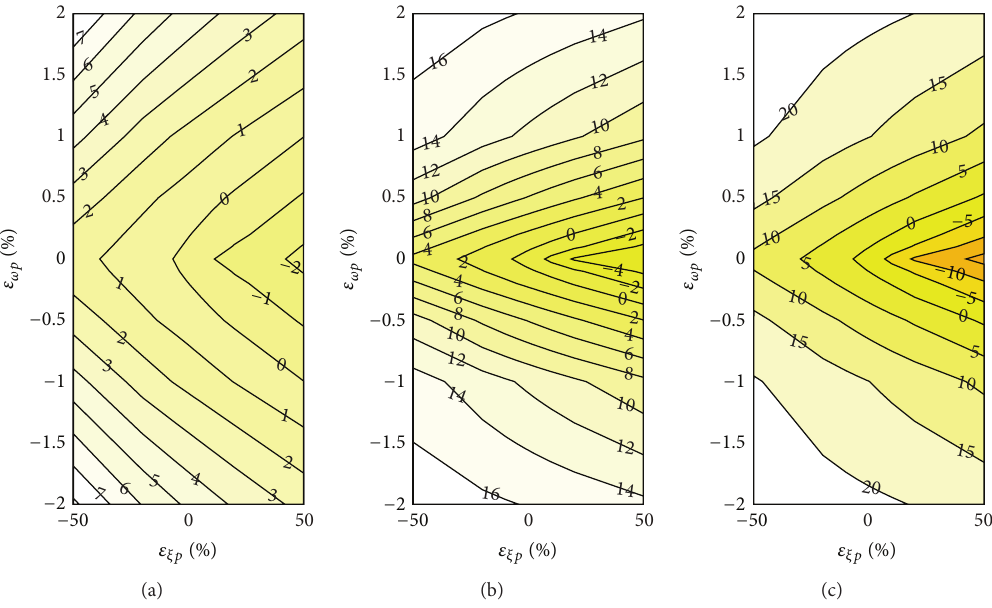
Figure 24: 𝜀 for case 17 (a), case 23 (b), and case 27 (c). perf